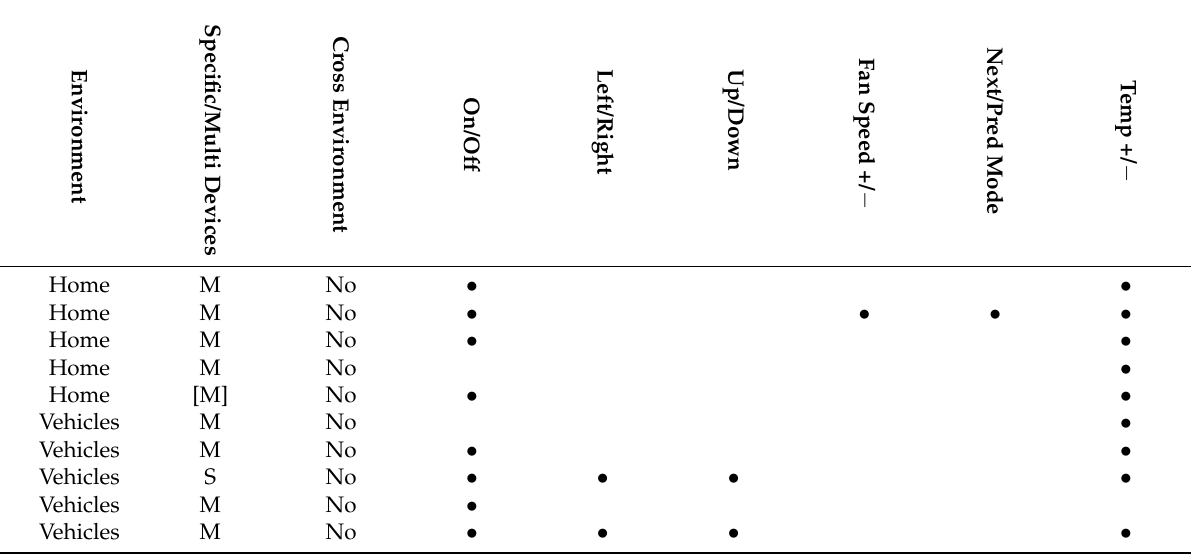
Table 1. A comparison of hand gesture studies based on the environment, whether AC is the only studied device, and the AC commands. M: multi devices [M] partially supporting multi devices; S: specific device; • :